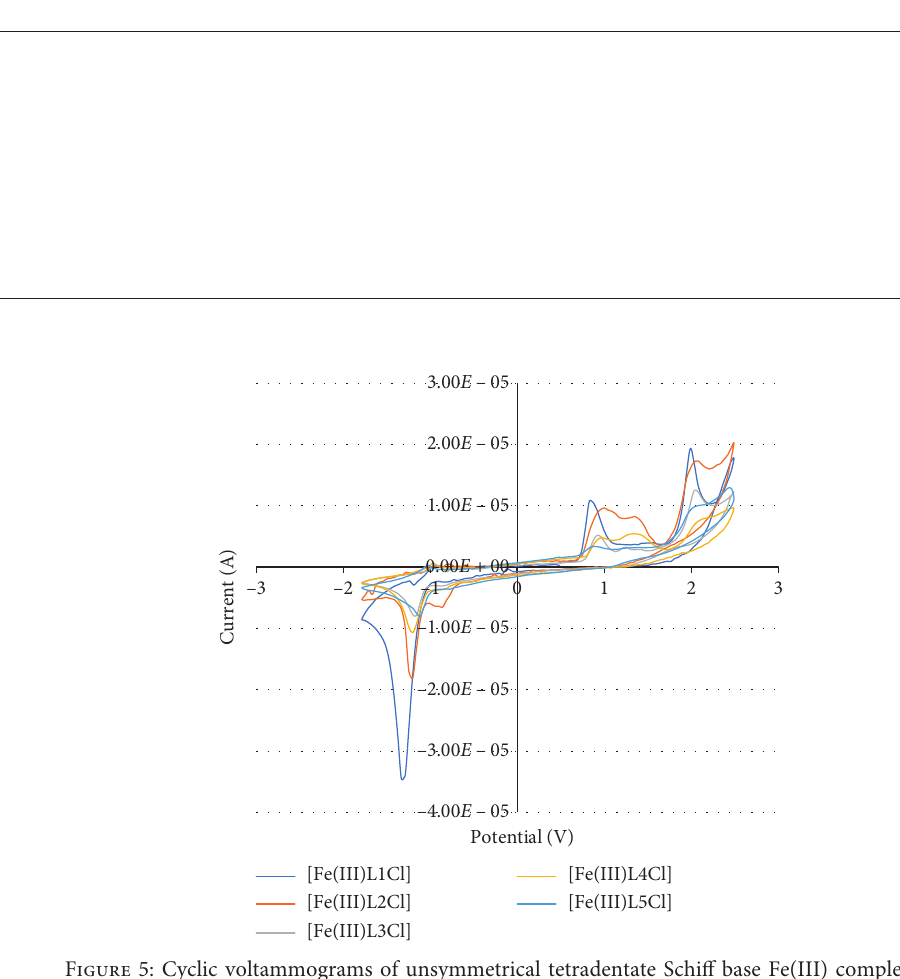
Table 4: Reduction potentials of synthetic Cu(II) and Fe(III) complexes.